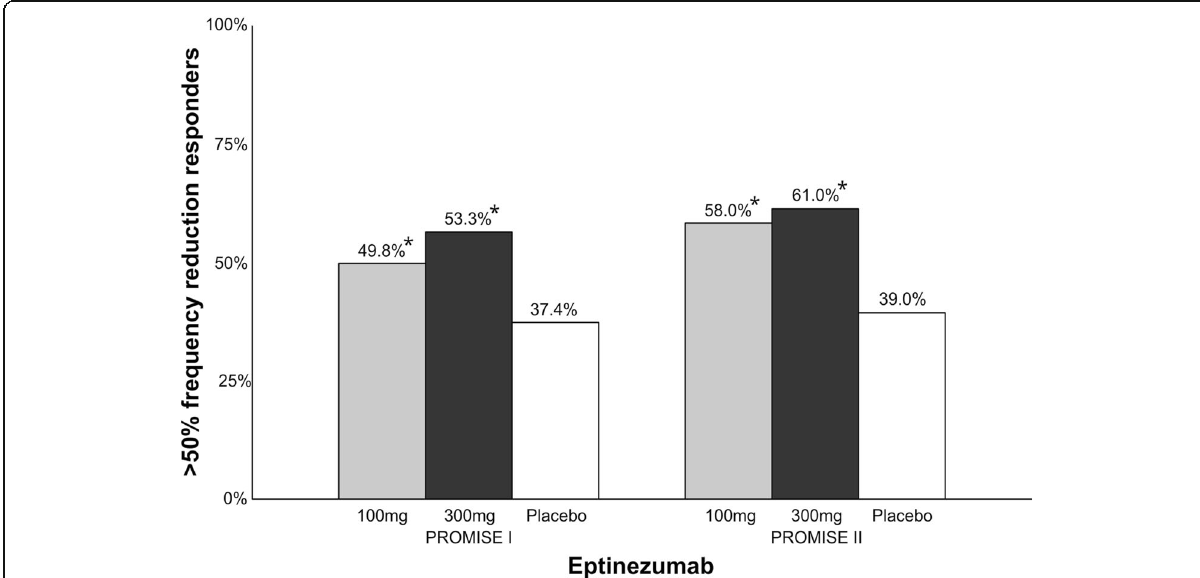
Fig. 8 Overview of patients (%) achieving > 50% reduction in migraine days in phase III clinical trials with eptinezumab. A darker bar indicates a higher dose. *PROMISE I; 100 mg vs. placebo, p = 0.0085; 300 mg vs. placebo, p = 0.0001. PROMISE II; 100 mg vs. placebo, p < 0.0001; 300 mg